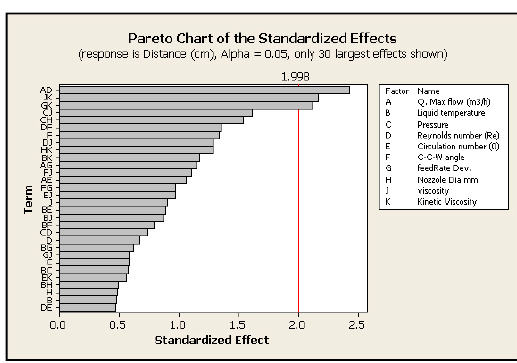
Figure 4. Waste movement of liquid bubbles.